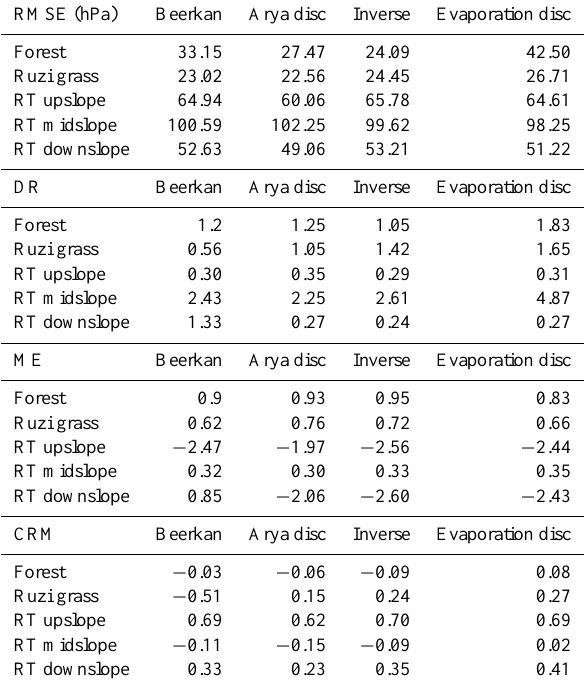
Table 5. Four modeling evaluation criteria for matric potential for the different situations with the different parameters used in Hy-